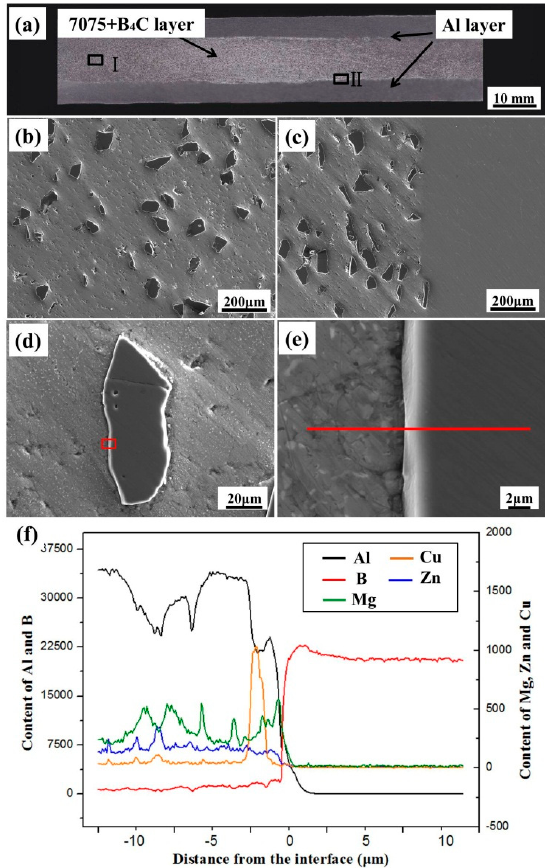
Figure 5. ( a ) The macrostructure of three-layered composite cross-section, and the microstructures of ( b ) the inner 7075-B 4 C layer and ( c ) interface between layers, as well as ( d ) a magnified morphology of the optional B 4 C particle from the inner layer; ( e ) a magnified interfacial morphology between B 4 C, the 7075 matrix, and the marked line scanning position; and ( f ) the line-scanning analysis results for the Al, B, Cu, Zn, and Mg elements.